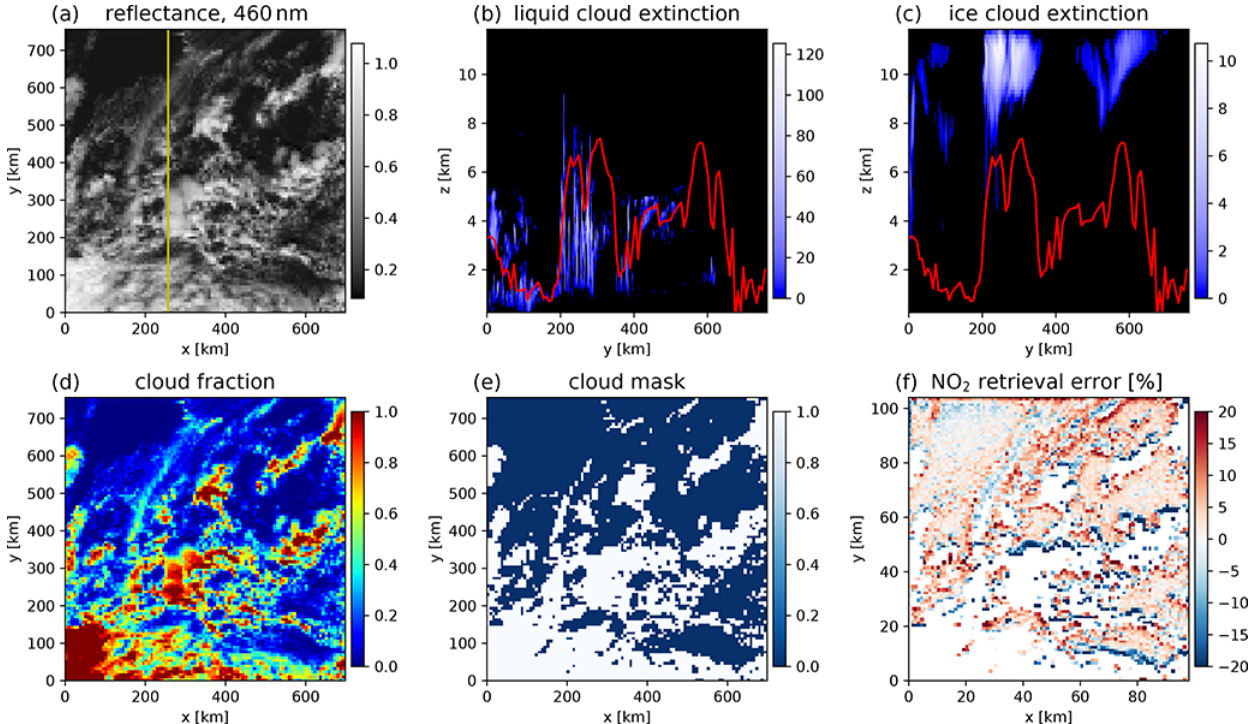
Figure 12. (a) Simulated reflectance at a spatial resolution of approximately 7km × 7km. Vertical cross sections of extinction coefficients of liquid (b) and ice water clouds (c) , along the yellow line drawn on the reflectance image. The red lines correspond to the effective cloud height derived from the O 2 –O 2 absorption band. (d) Retrieved weighted radiometric cloud fraction, (e) cloud mask (all pixels with a cloud fraction larger than 0.3 (white) are excluded from the NO 2 retrieval) and (f) NO 2 retrieval